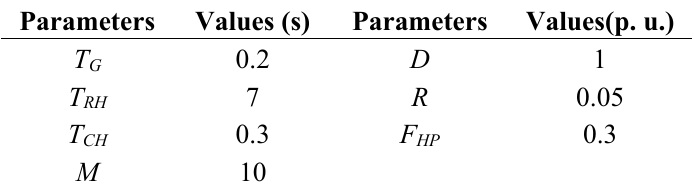
Figure 11. Single line diagram of the IEEE 9-bus test system. Table 3. Parameters of generating